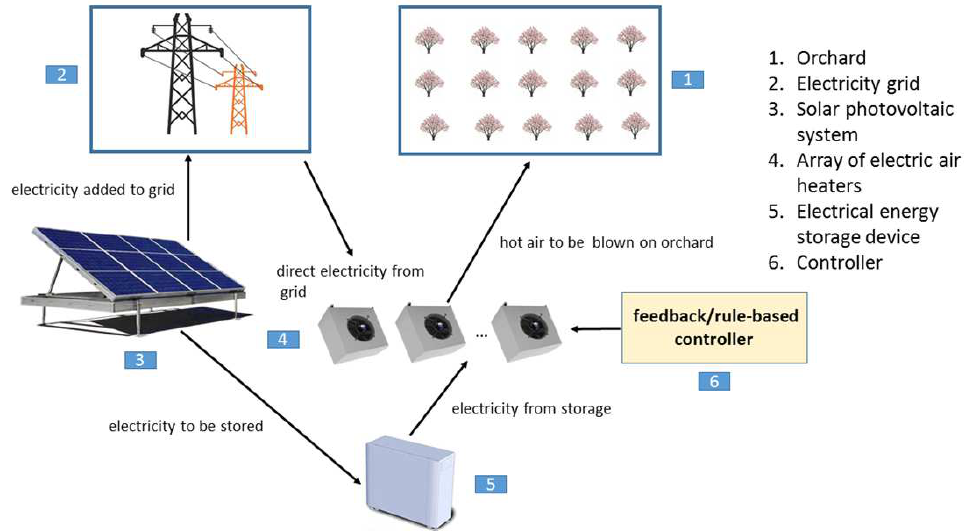
Figure 9. PV-integrated frost prevention system